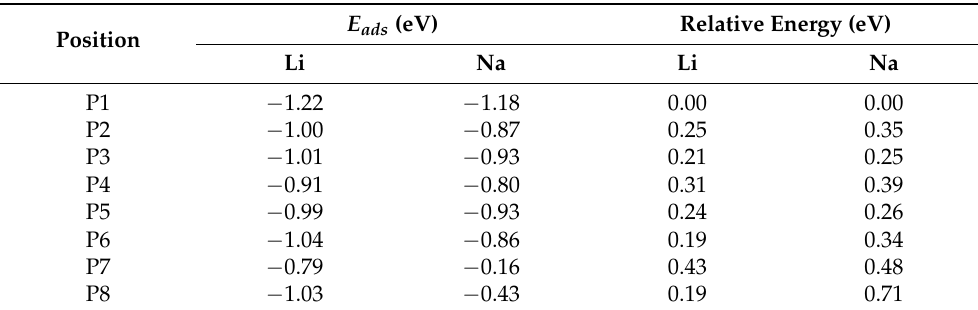
Table 1. The adsorption energy of a single alkali-metal atom on the A’-MoS 2 surface and the energy difference calculated relative to position